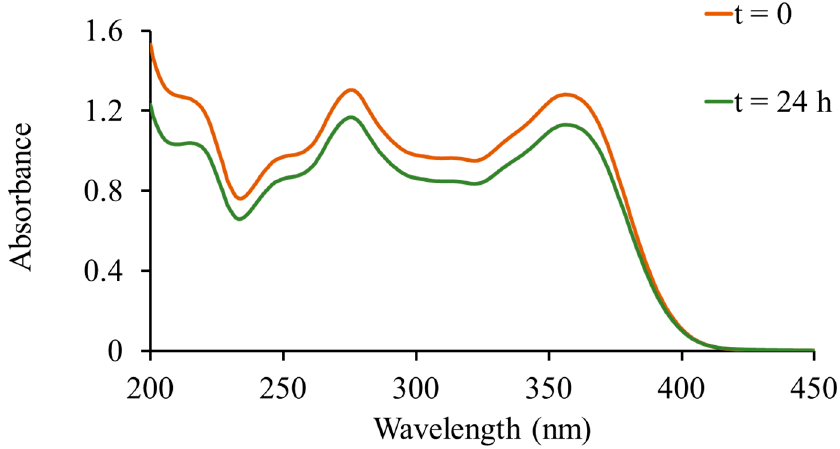
Figure 2. UV-Vis spectra of tetracycline at 0 and 24 h. A slight downward shift in the spectra was observed at 24 h.